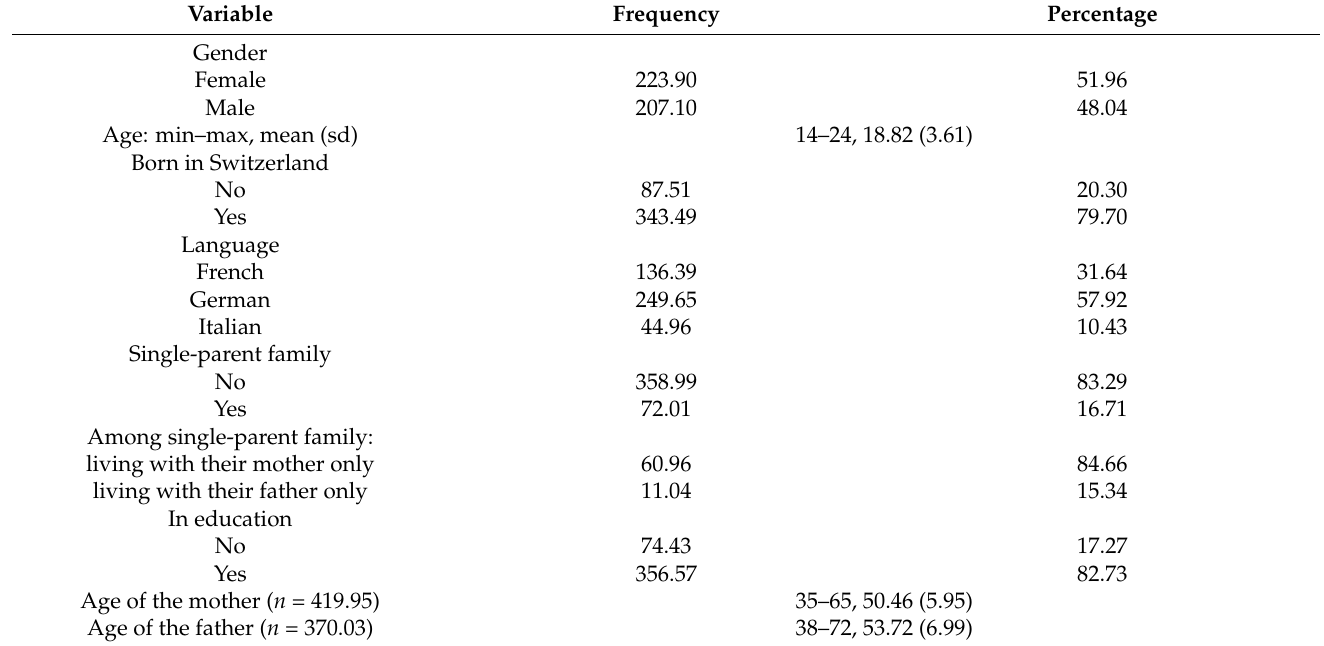
Table 1. Description of the sample of